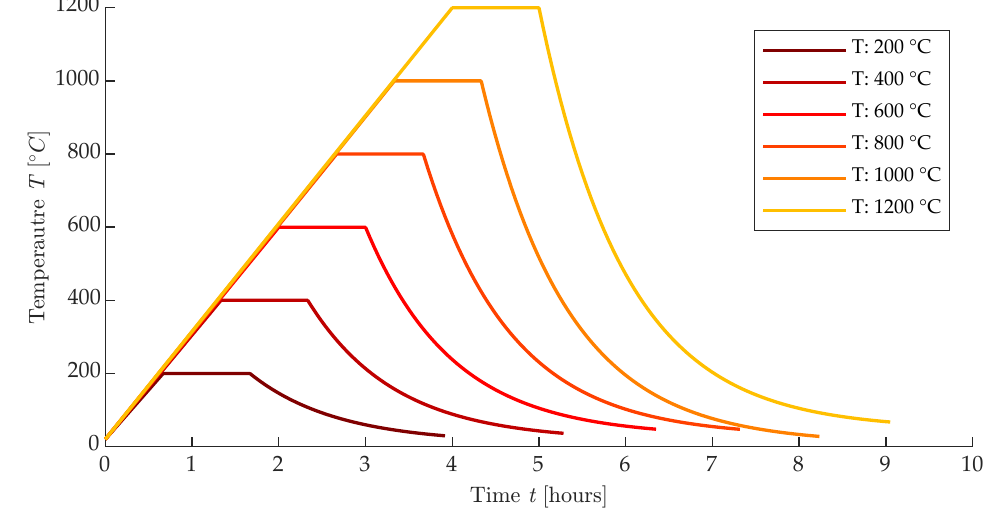
Figure 2. Illustration of temperature curves for all degraded